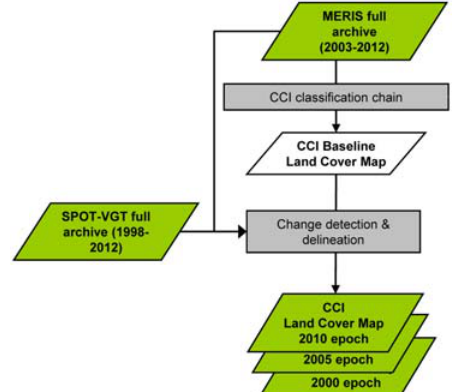
Figure 4. Classification workflow developed to generate global LC maps stable over time